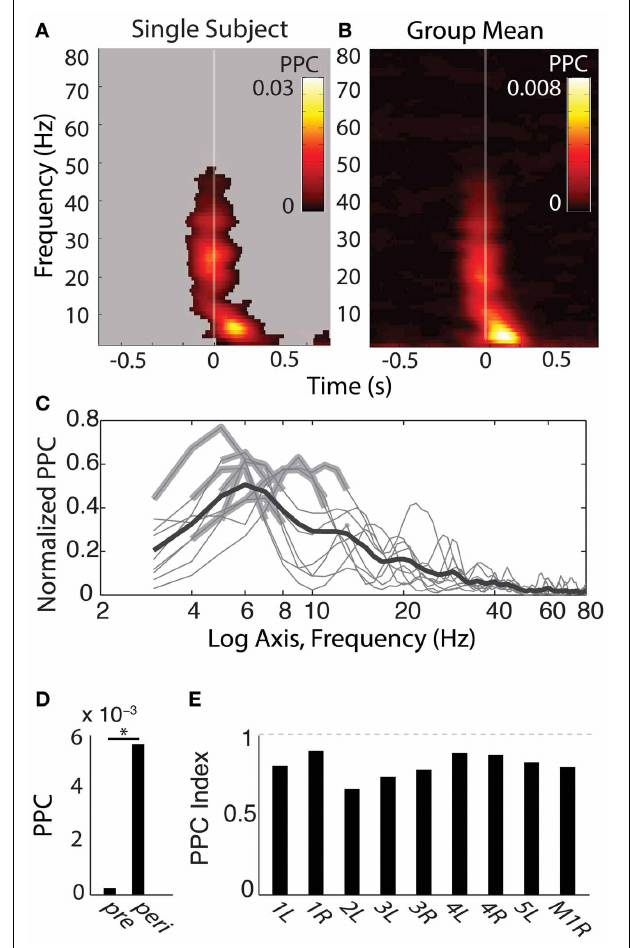
FIGURE 4 | Phase-alignment to fixations during search shows specificity in frequency and time. (A) Single-subject theta-band phase-locking to fixations. Shown is the pairwise phase consistency (PPC) for each time-frequency bin described in Figure 3 , with time on the x axis relative to fixation onset and frequency on the y-axis. Significant PPC values are unmasked ( p < 0 . 001 of fixation-time-shuffled distribution and Rayleigh test p < 0 . 001 FDR corrected). (B) Group-averaged PPC plots for each hippocampus sampled. Conventions are as in (A) , but for the mean PPC values, with no masking. (C) Frequency band-limited hippocampal phase alignment to fixations, across subjects. For each frequency indicated on the x axis, the y-axis shows the mean PPC value from time-frequency points centered − 50 to 250ms from fixation onset, expressed as the proportion of the maximal PPC value of that sample from 3 to 80Hz and − 800 to 800ms. Each thin line reflects the normalized PPC from a single hippocampus, with significant frequency bands indicated with a thickened gray line; all hippocampi produced significant phase concentration within a 3–8Hz band; none produced significant phase concentration above 12Hz. The black bold line is the group-averaged mean ( N = 9). (D) Peri-fixational phase alignment, group averages pre and peri-fixation. Average PPC values from time bins centered − 50 to 250ms from fixation onset were compared with PPC values − 800 to − 600ms prior to each fixation. ∗ p < 0 . 01, Wilcoxon signed rank test. (E) Bars reflect the PPC values from each hippocampus recorded, indexed as the difference between the pre- and peri-fixational time windows (see Materials and Methods). Participant number and hemisphere are indicated below each